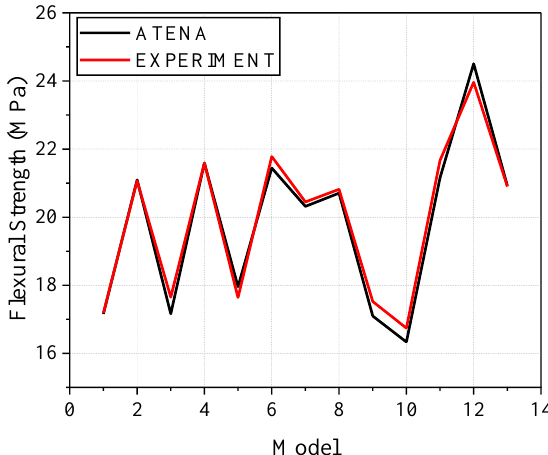
Figure 4. Flexural stress verification. Table 5. Error estimation for flexural stress.